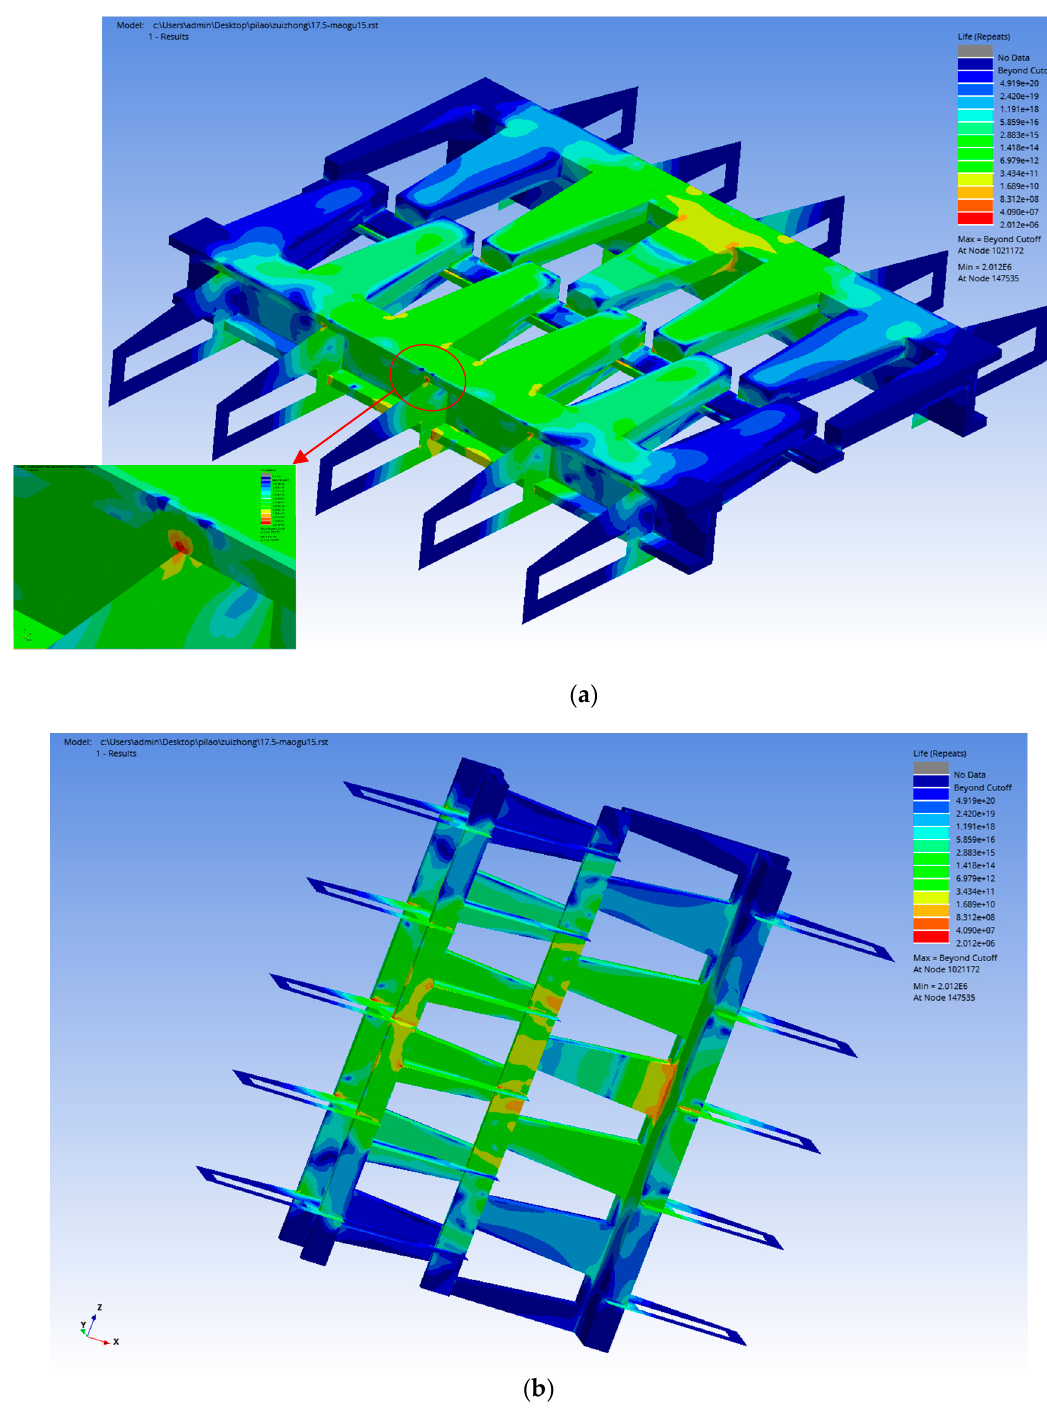
Figure 19. The fatigue life of comb plate expansion joint:( a ) View from the top, ( b ) View from the bottom. Table 7. Results of fatigue life